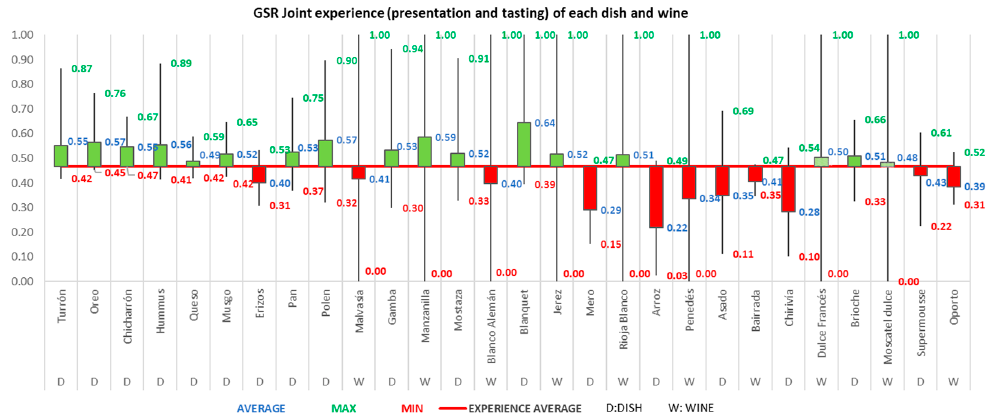
Figure 6. GSR joint analysis of presentation and tasting for each dish and wine. Source: Original work from the authors.